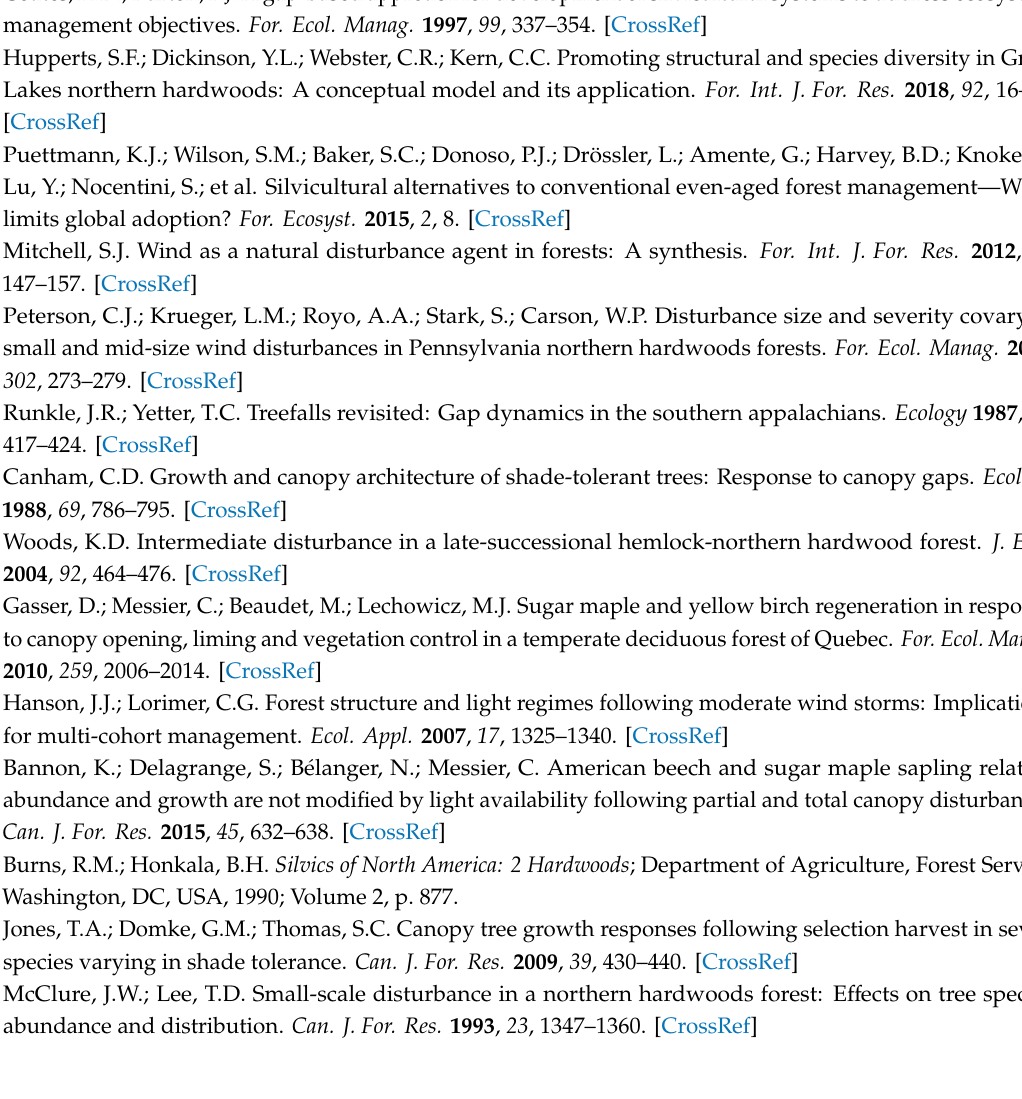
species or species pool. Table S6. Simple linear regressions between various regeneration indices, separately for sugar maple and yellow birch. Table S7. Multiple linear regressions (Type III F -tests) between regeneration indices in year 15 (response) and environmental factors (explanatory). Table S8. Multiple linear regressions (Type III F -tests) between regeneration indices in year 15, on the one hand (response), and both environmental factors and regeneration indices, on the other hand (explanatory). Table S9. Contingency table of dominant species per quadrat in early years (year 2 and 5) after harvest compared with year